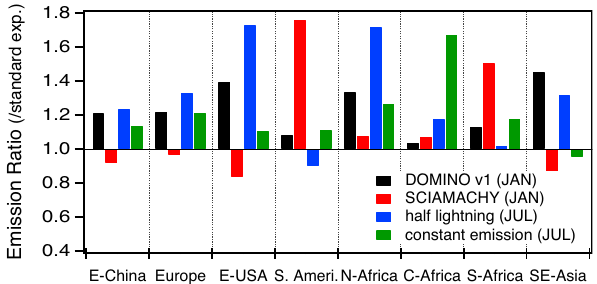
Fig. 13. Ratios of the regional mean NO x emissions between the standard assimilation experiments using the DOMINO v2 obser- vations and experiments conducted using different satellite prod- ucts: the DOMINO v1 retrieval (black bars) and the SCIAMACHY retrieval (red bars) in January. Also shown are the emission ra- tios between the standard assimilation experiments and experiments conducted using different model settings: a 50% reduction of NO x emissions by lightning (blue bars) and without the diurnal variabil- ity scheme for the surface emissions (green bars) in July. The ratio greater (less) than one indicates that the NO x emissions are higher (lower) in the sensitivity experiments than in the standard assimila- tion